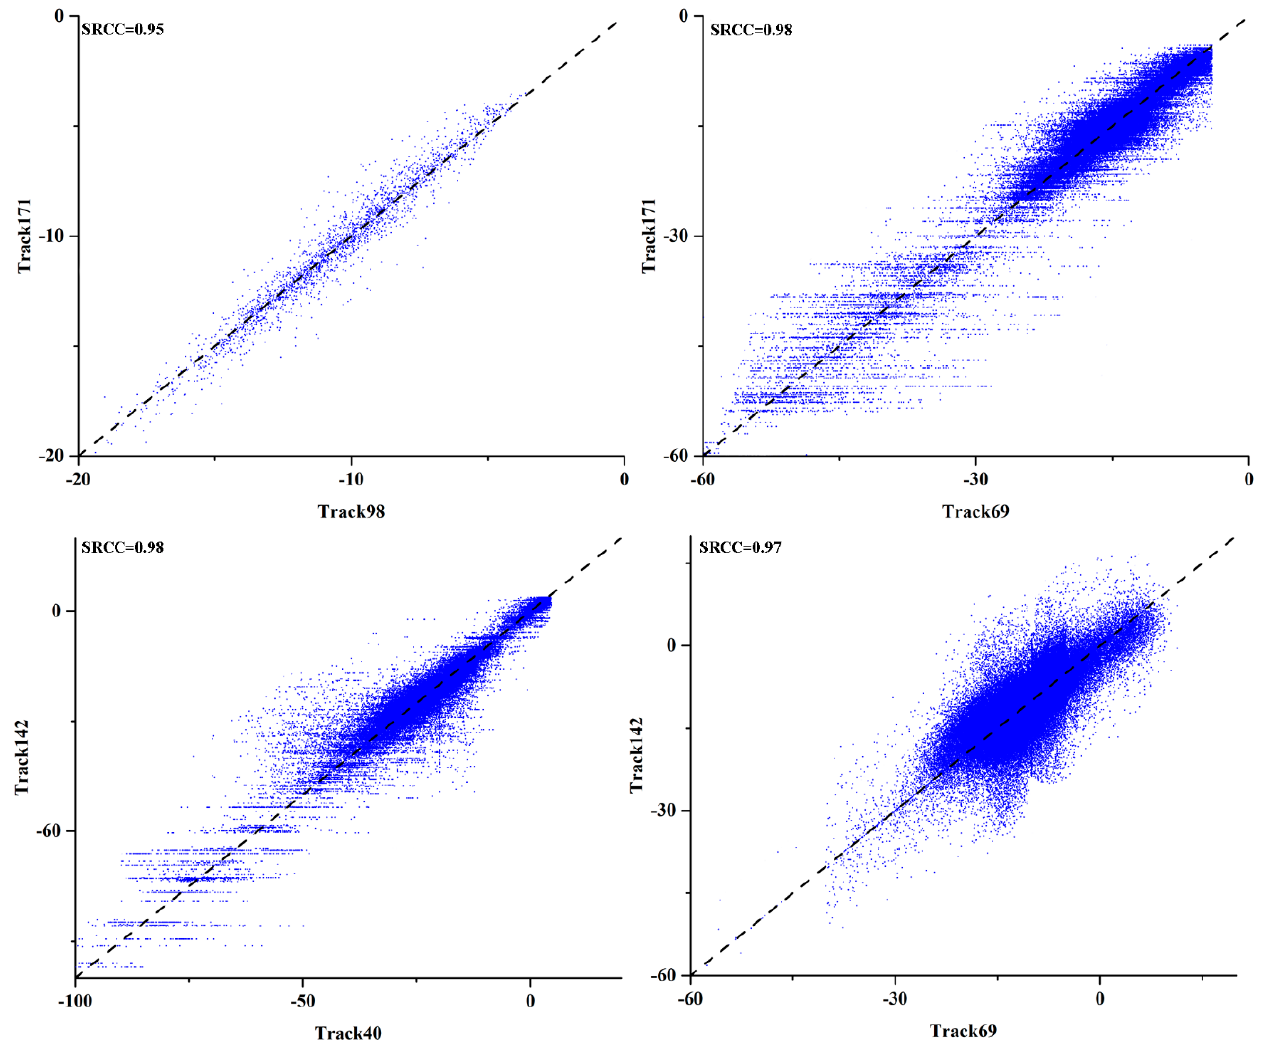
Figure 7. Consistency among the land subsidence rates in PS-InSAR monitoring results derived from different tracks.